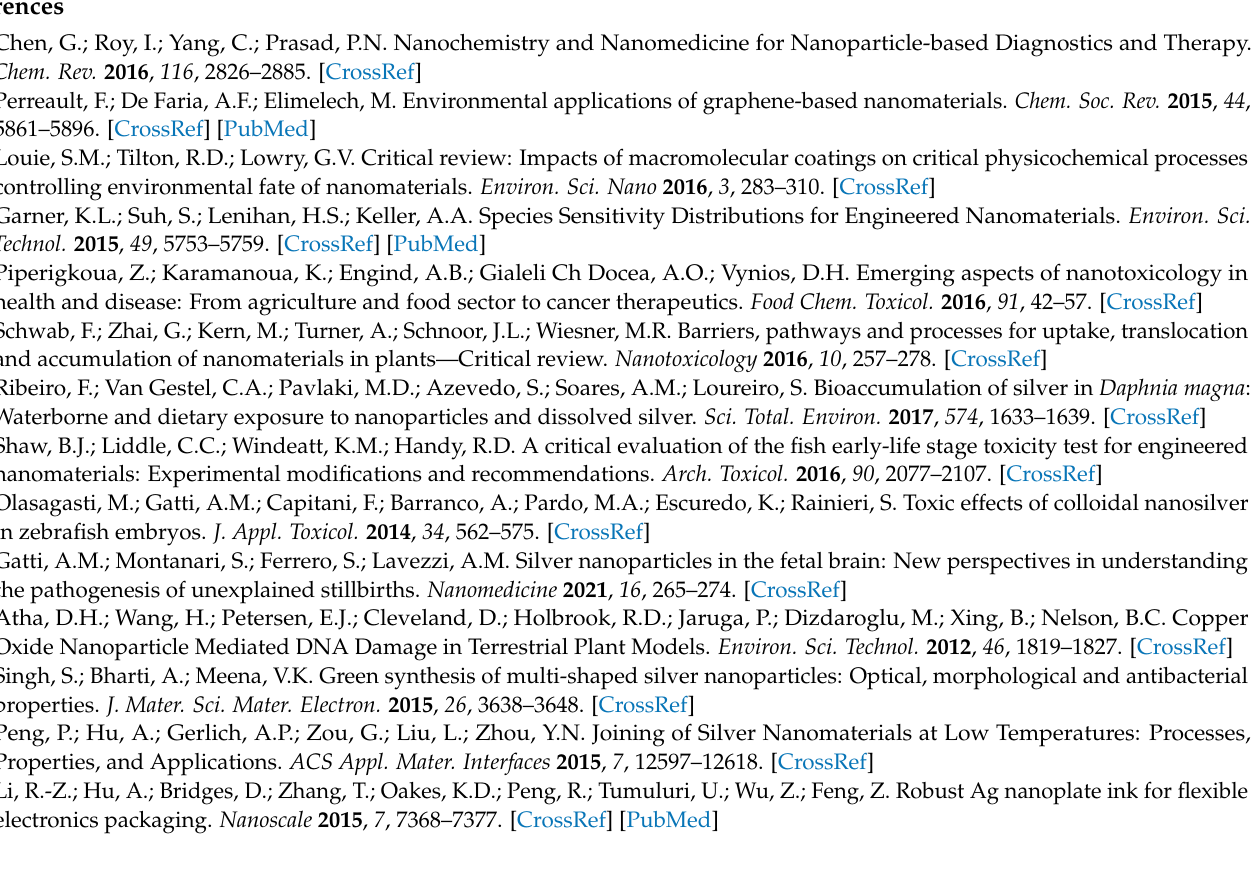
(<5 ppm) during the observation time with the same Ag concentration. Figure S3. Root length of Lolium multiflorum after several days of exposure of 40mg/L of Ag@PDS, AgNO 3 , and AgNPs. Figure S4. Effect of DI, KNO 3 , PDS, AgNO 3 , Ag@PDS, and AgNPs on the Lolium multiflorum length ( a ) and mass ( b ) after 7 days of exposure. Figure S4. Effect of Ag@PDS, AgNO 3 , and AgNPs on the Lolium multiflorum root ( a , c ) and shoot ( b , d ) mass after 7 days of exposure ( p ≤ 0.05). Figure S5. TEM images of polydopamine spheres loaded with silver nanoparticles (Ag@PDS) with 50 nm scale bar. Figure S6. Images of LB-agar plates, which were used in the antibacterial activity experiment of samples against E.coli : control ( a ), polydopamine (PDS) ( b ), polydopamine sphere loaded with silver nanoparticles (Ag@PDS) ( c